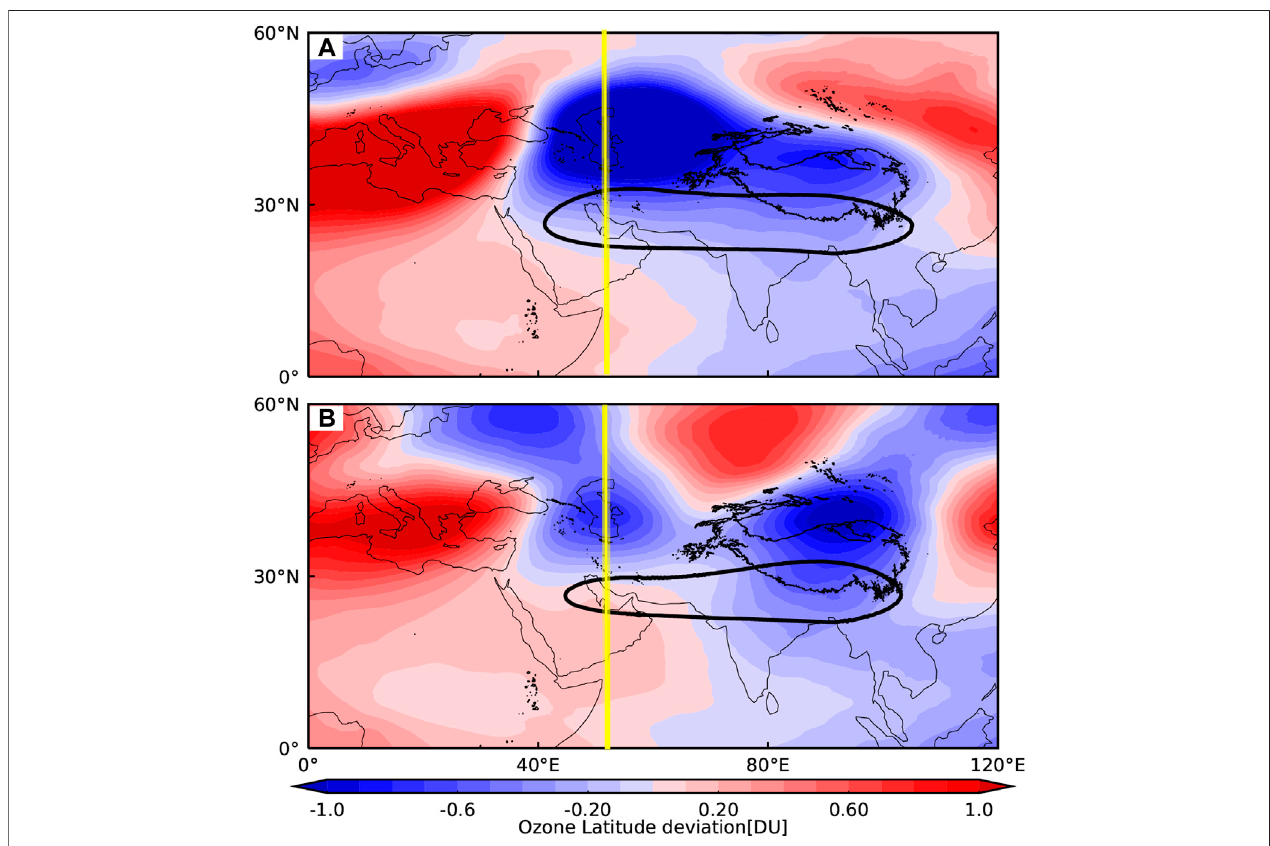
FIGURE 11 | The composite TCO* (shading, unit: DU) and the SAH region (solid lines, 12,520 gpm geopotential height isolines) for the EOF time series 2 in the (A) stronger years and (B) weaker years. The yellow lines are the longitude of 50 ° E.